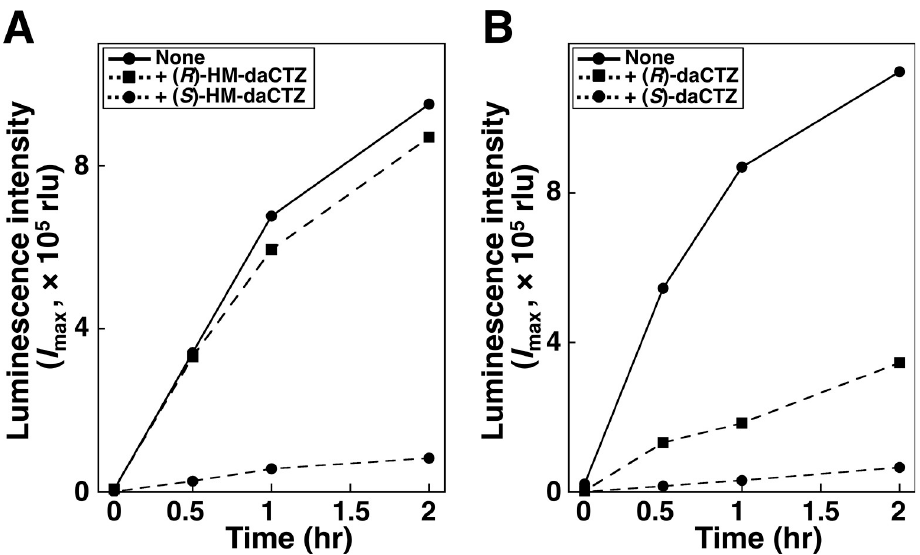
Fig 5. Inhibition of aequorin regeneration from apoAequorin and coelenterazine in the presence of chiral deaza- coelenterazine analog. A. Time course of aequorin regeneration from apoAequorin and coelenterazine in the presence of ( R )-2- and ( S )-2-hydroxymethyl deaza-CTZ (HM-daCTZ). B. Time course of aequorin regeneration from apoAequorin and coelenterazine in the presence of ( S )- and ( R )-deaza-CTZ (daCTZ). The reaction conditions are described in Table